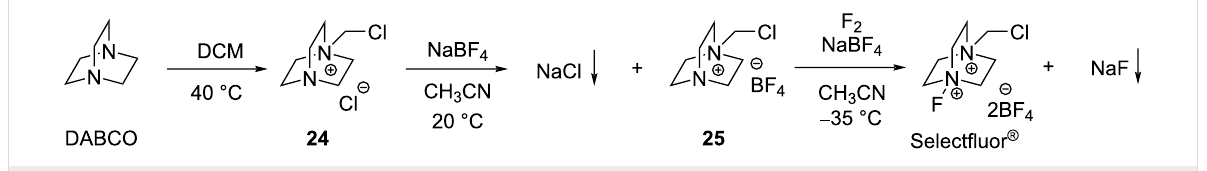
Scheme 3: Synthesis of Selectfluor ® .